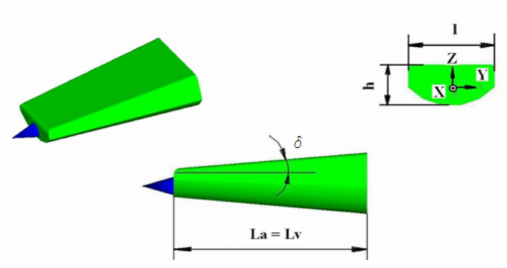
Figure 4. The first part of fuselage.